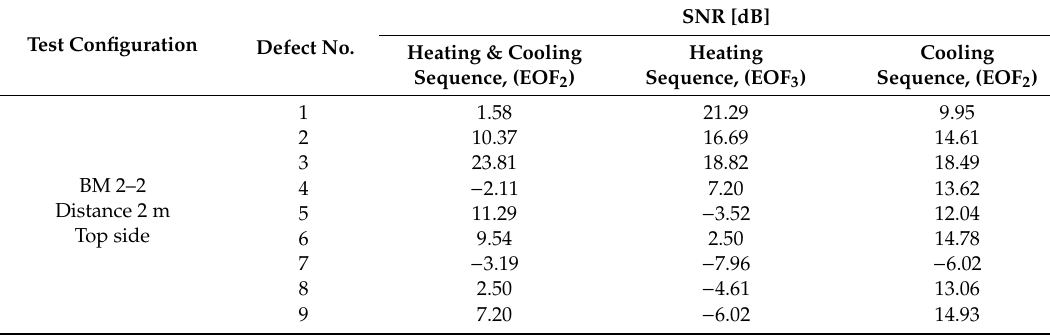
Figure 13. PCT, BM 1–1 bottom side: ( a ) cooling sequence, distance 1.5m, (EOF 2 ); ( b ) heating & cooling sequence, distance 1.5m, (EOF 3 ); ( c ) cooling sequence, distance 2m, (EOF 2 ); ( d ) heating & cooling sequence, distance 2m, (EOF 4 ); ( e ) cooling sequence, distance 3m, (EOF 2 ); ( f ) heating & cooling sequence, distance 3m, (EOF 3 ).